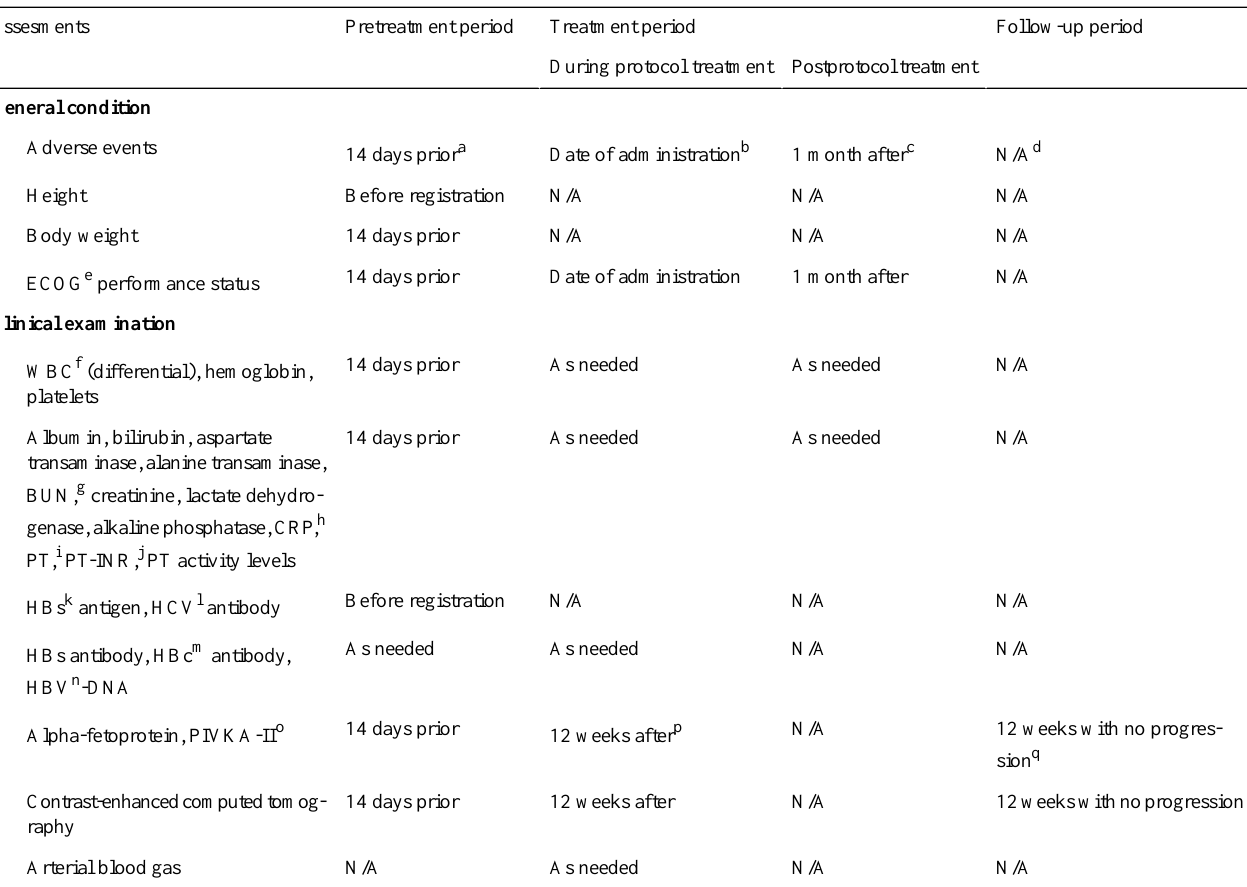
Follow-up periodTreatment periodPretreatment periodAssesments